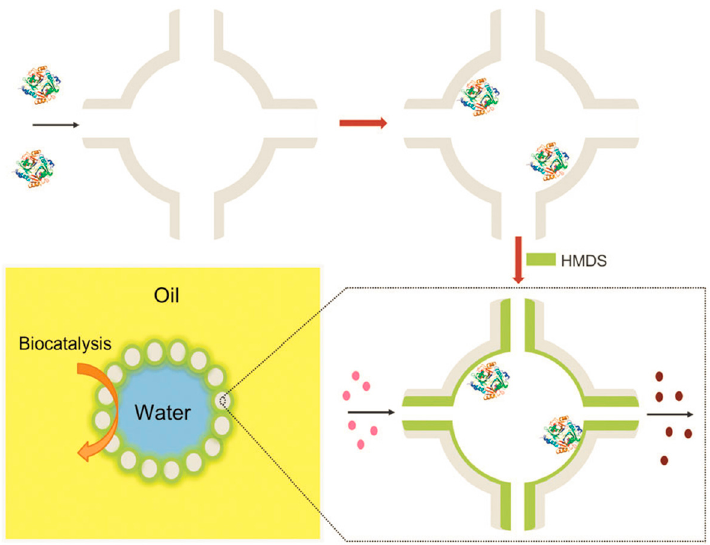
Figure 6. The schematic illustration of the strategy to encapsulate enzymes into the nanocage of FDU-12 using hexamethyldisilazane (HMDS) as the silylation reagent, and the Pickering emulsion stabilized by modified FDU-12 particles with enzymes confined in the nanocages to perform biphasic enzymatic reactions (reproduced with permission from [87], Copyright 2013, Royal Society of Chemistry).